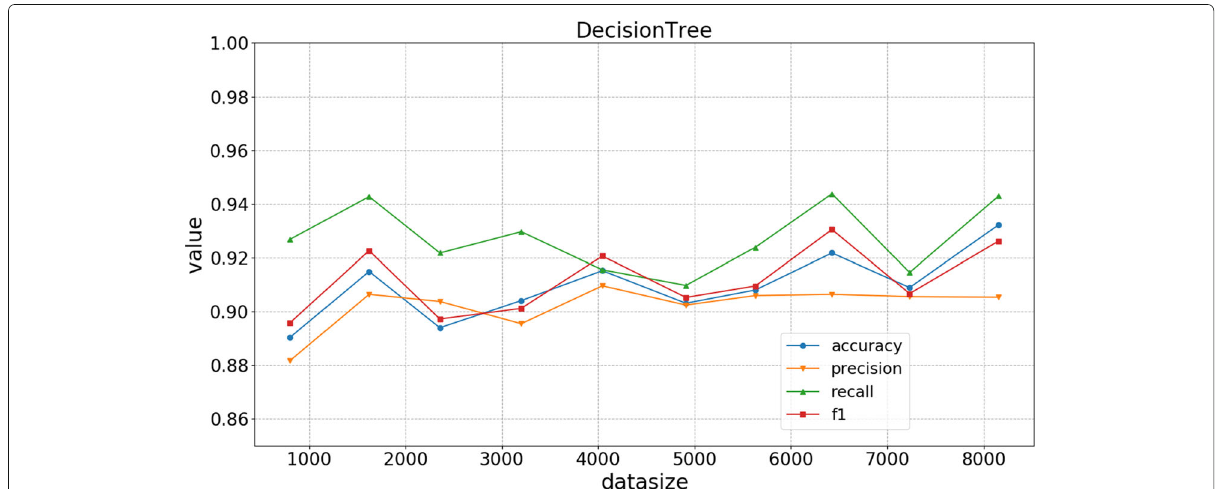
Fig. 12 Result of DT with different training set size. We test the Decision Tree classifier using subsets with the following sizes: 803, 1622, 2357, 3201, 4043, 4909, 5628, 6425, 7230, and 8155, where the ratio of positive/negative is close to 1. The accuracy is high, which is above 95%. With the increase of the data size, the results get